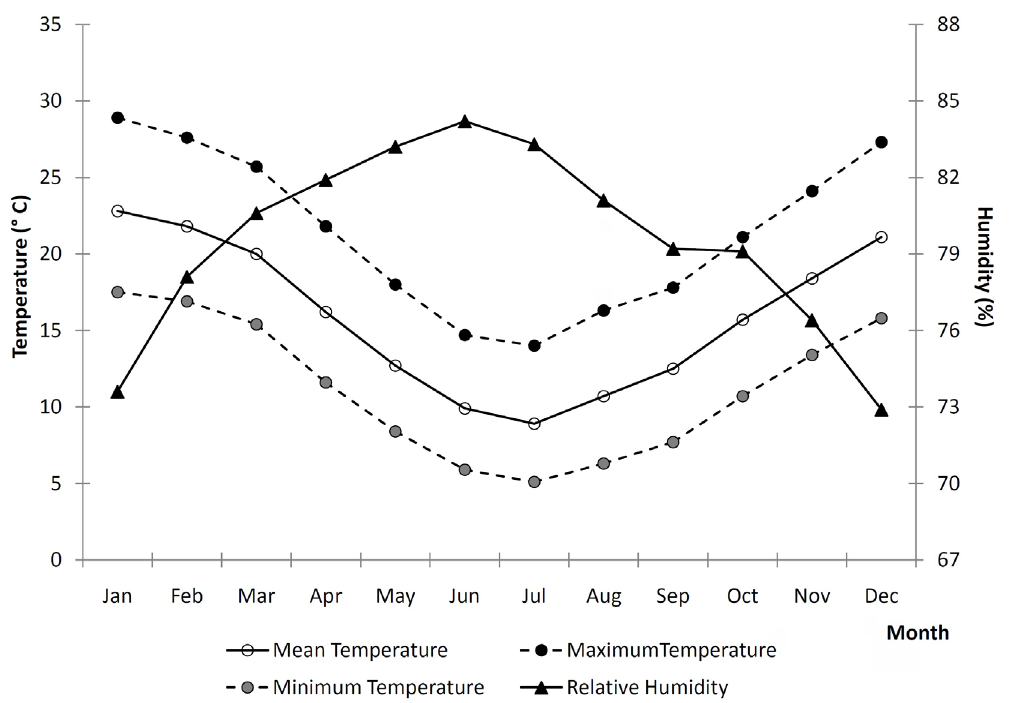
Figure 1. Monthly average variation of the mean, maximum and minimum temperature and relative humidity in La Plata corresponding to the period